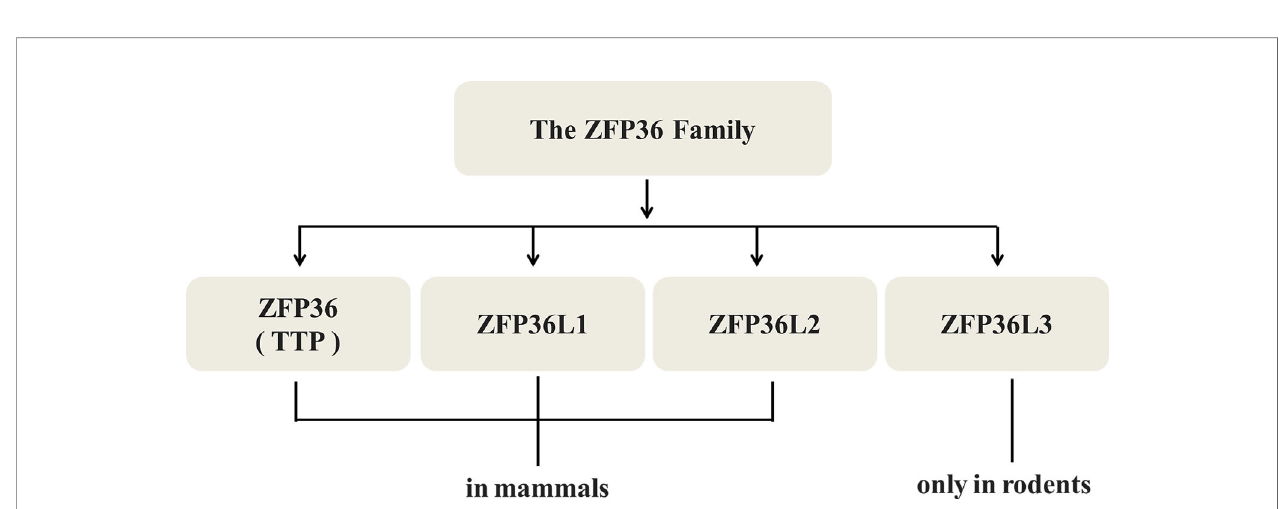
FIGURE 2 | Types of TTP/ZFP36. TTP/ZFP36 along with ZFP36L1 and L2, all members of the ZFP36 family share similar structures and functions in mammals, while L3 is found only in rodents.